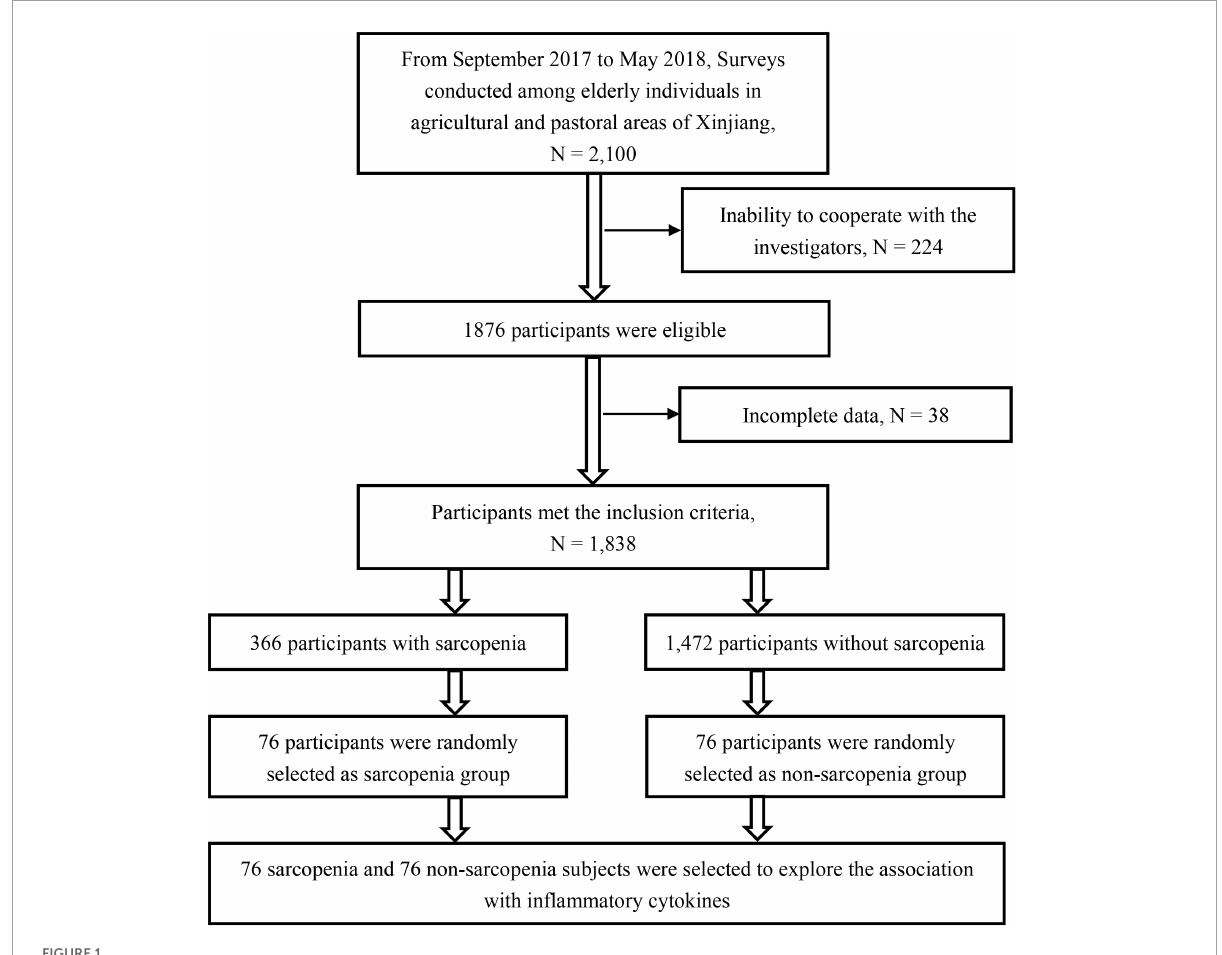
FIGURE1 Selection procedure of the study